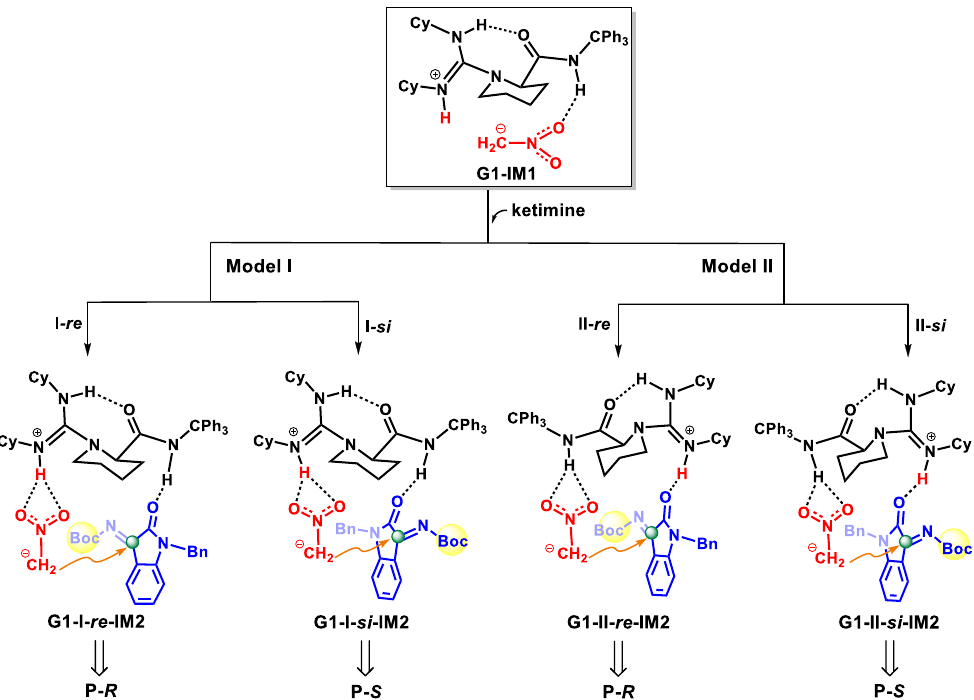
Scheme 3. Four possible reaction pathways along re - or si -face attacks to obtain the R - or S -configuration products, respectively.